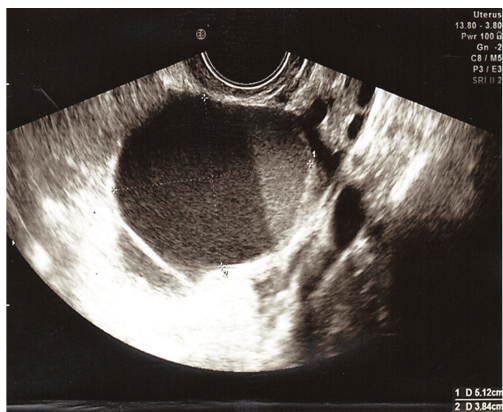
Figure 1: Pelvic ultrasound, showing a large complex ovarian cyst with layered low level echoes measuring 5.1 × 3.8 cm.